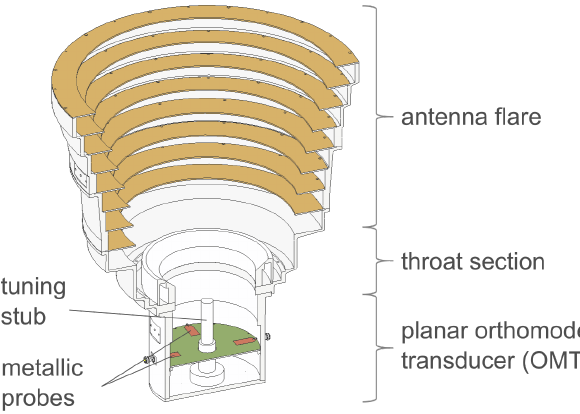
Figure 2. Cut through the developed VEGA antenna showcasing its three sections. Together the antenna flare, throat section and planar orthomode transducer (OMT) are able to produce two distinct orthogonal linear